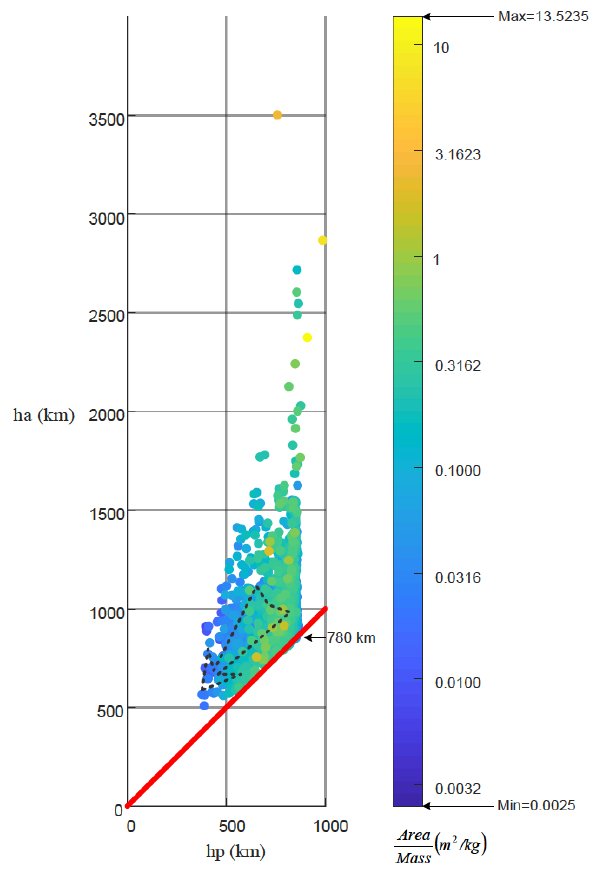
Figure 12. Orbital distribution of LEO space debris